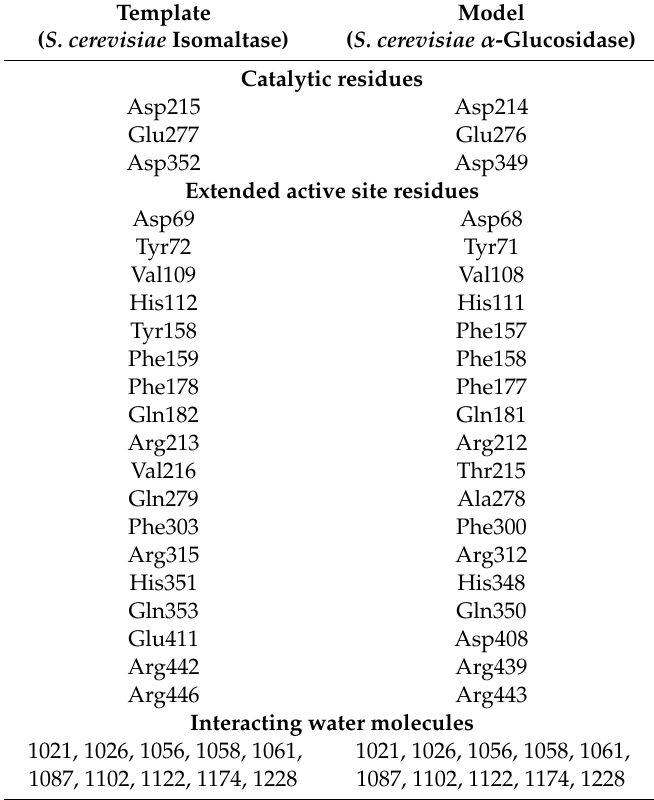
Table 3. Comparison of active site residues of template and model structures.